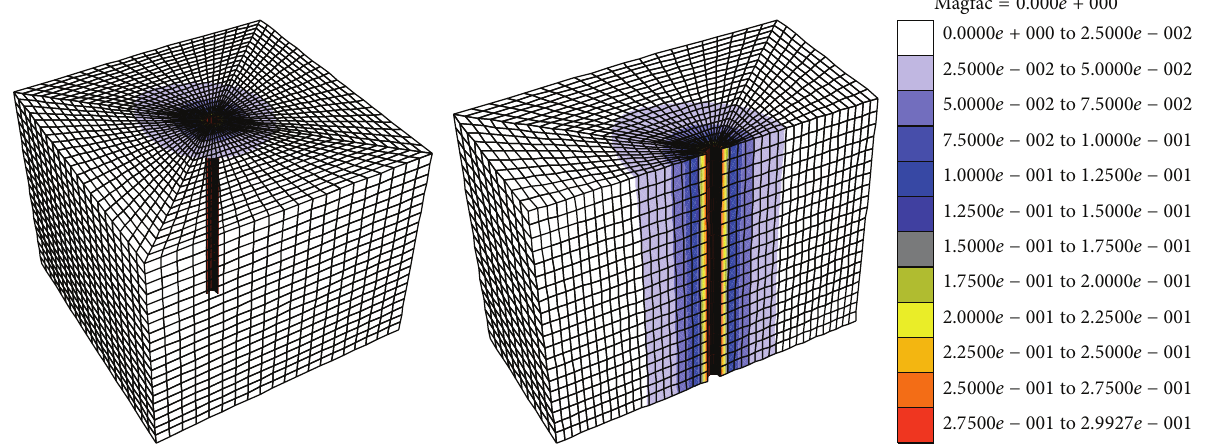
Contour of displacement mag.